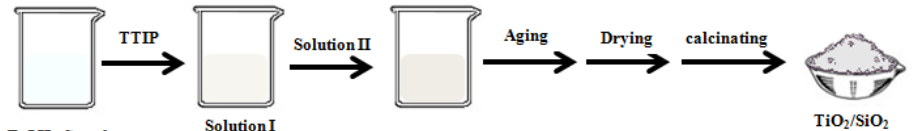
Fig. 2. Diagrammatic synthesis of TiO 2 /SiO 2 samples in the presence of starch via sol-gel method